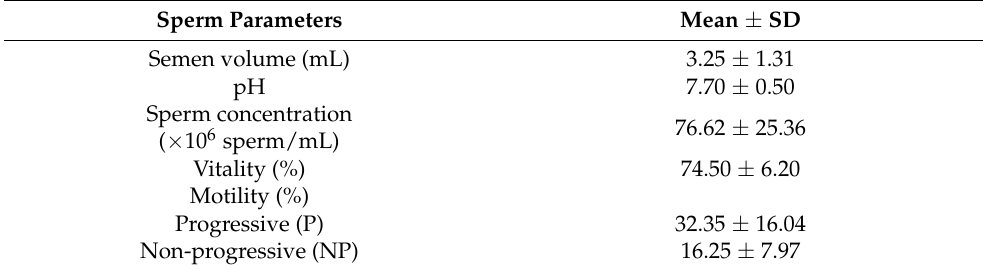
Table 1. Parameters of semen fluid selected for the study expressed as mean ± SD.